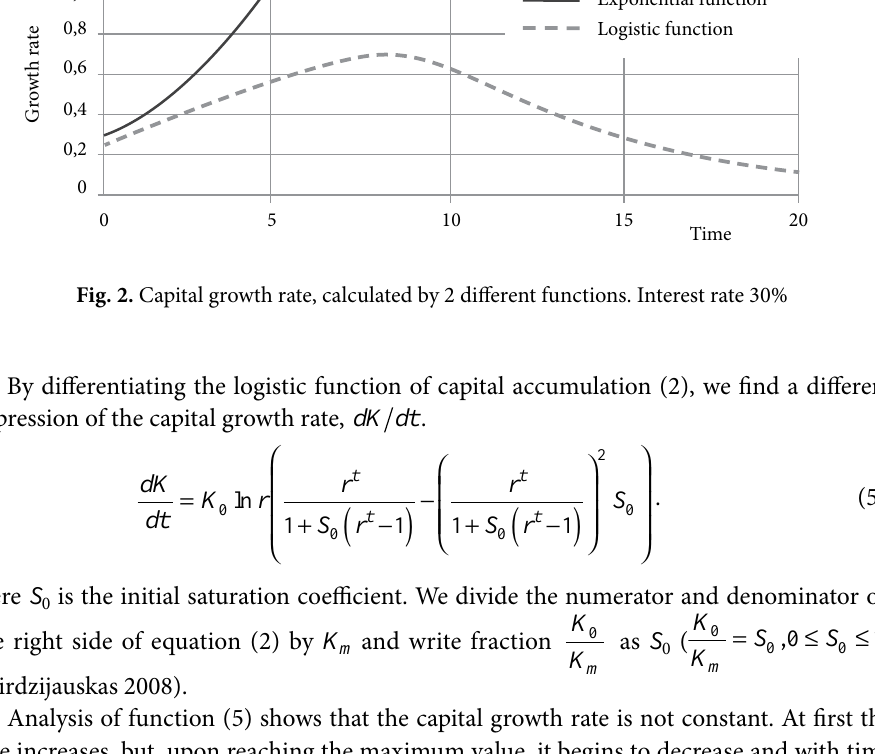
Exponential function Logistic